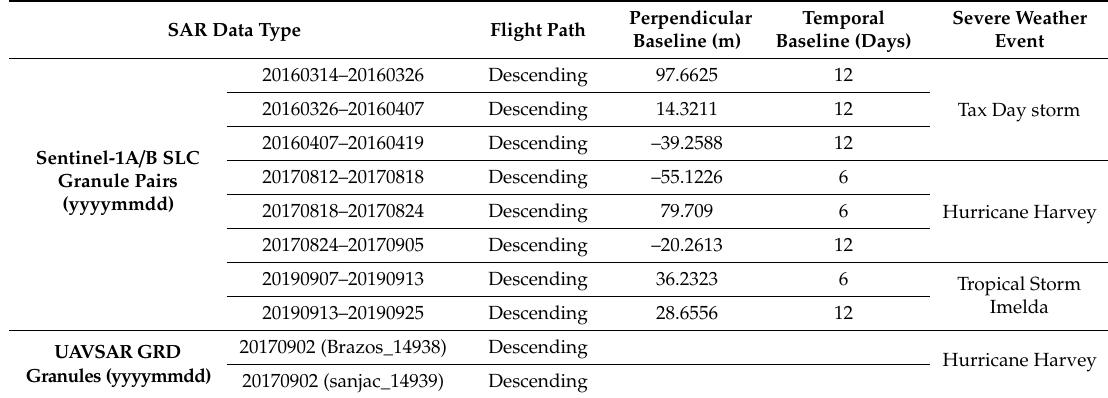
Table 1. Synthetic Aperture Radar (SAR) datasets used for mapping and validating the flood occurrences following severe weather events in the study